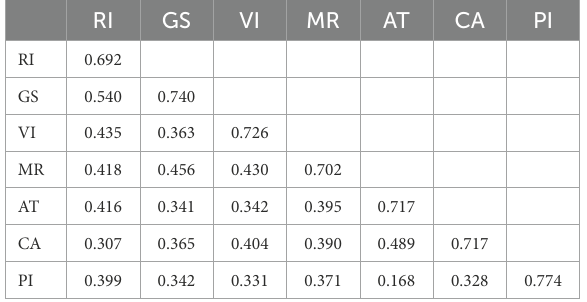
TABLE 4 Cross-factor loading analysis. TABLE 5 Correlation coefficients between variables.